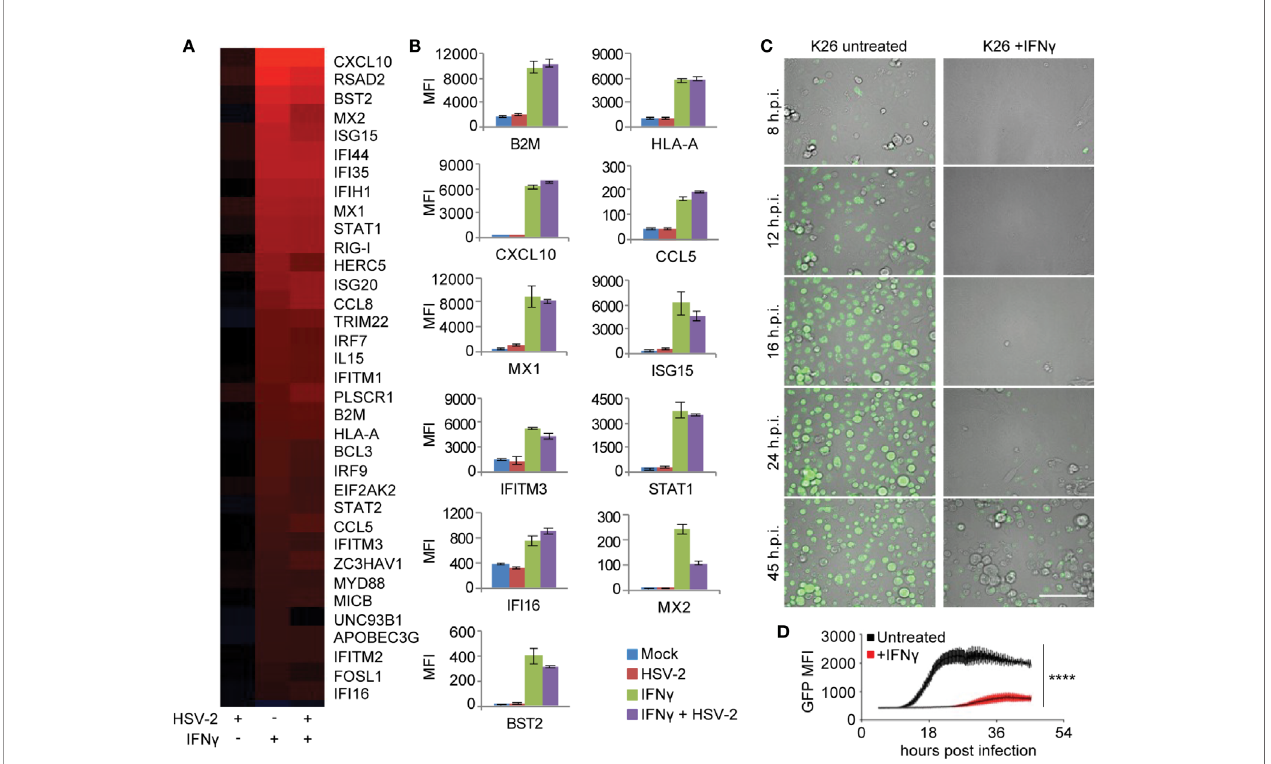
FIGURE 4 | IFN- g mediated antiviral (IMA) gene signature expression in primary human keratinocytes. (A) Signature genes differentially expressed by IFN- g treatment annotated to the GO term “ response to virus ” in primary cultured human keratinocytes. Column 1: Mock treated, HSV-2 infected, HG52 MOI=1, 4 h.p.i. Column 2: IFN- g treated, 100 U/ml for 48 hours and then mock infected. Column 3: IFN- g treated, 100 U/ml for 48 hours and then infected with HG52, MOI=1, 4 h.p.i. Analyses were done by comparing to mock-treated and mock-infected keratinocytes. All genes listed are signi fi cantly induced by IFN- g (FDR = 0.05). False discovery rates were derived from analysis of duplicate samples using Limma package in R. (B) Representative host gene expression in the functional category of antigen presentation, chemotaxis, and innate/cell-intrinsic antiviral defense. (C) Real-time monitoring of GFP expression in K26-infected primary human keratinocytes (MOI = 1, 45 h.p.i.), mock- treated or treated with IFN- g 100 U/ml, 48 hours. Scale bars, 100 µm. (D) Comparison of GFP signal intensity in K26-infected primary human keratinocytes with or without IFN- g treatment. ****p <